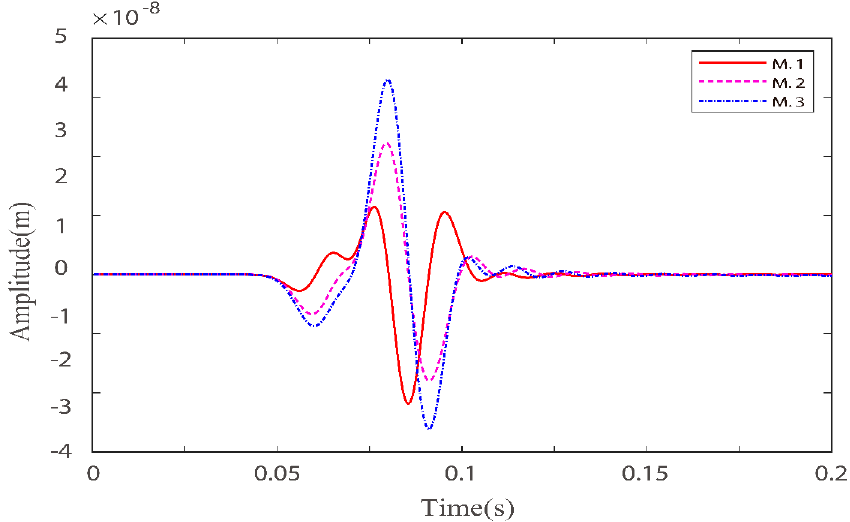
Figure 4. Comparison of liquid phase z–direction velocity components with three fluid viscosity